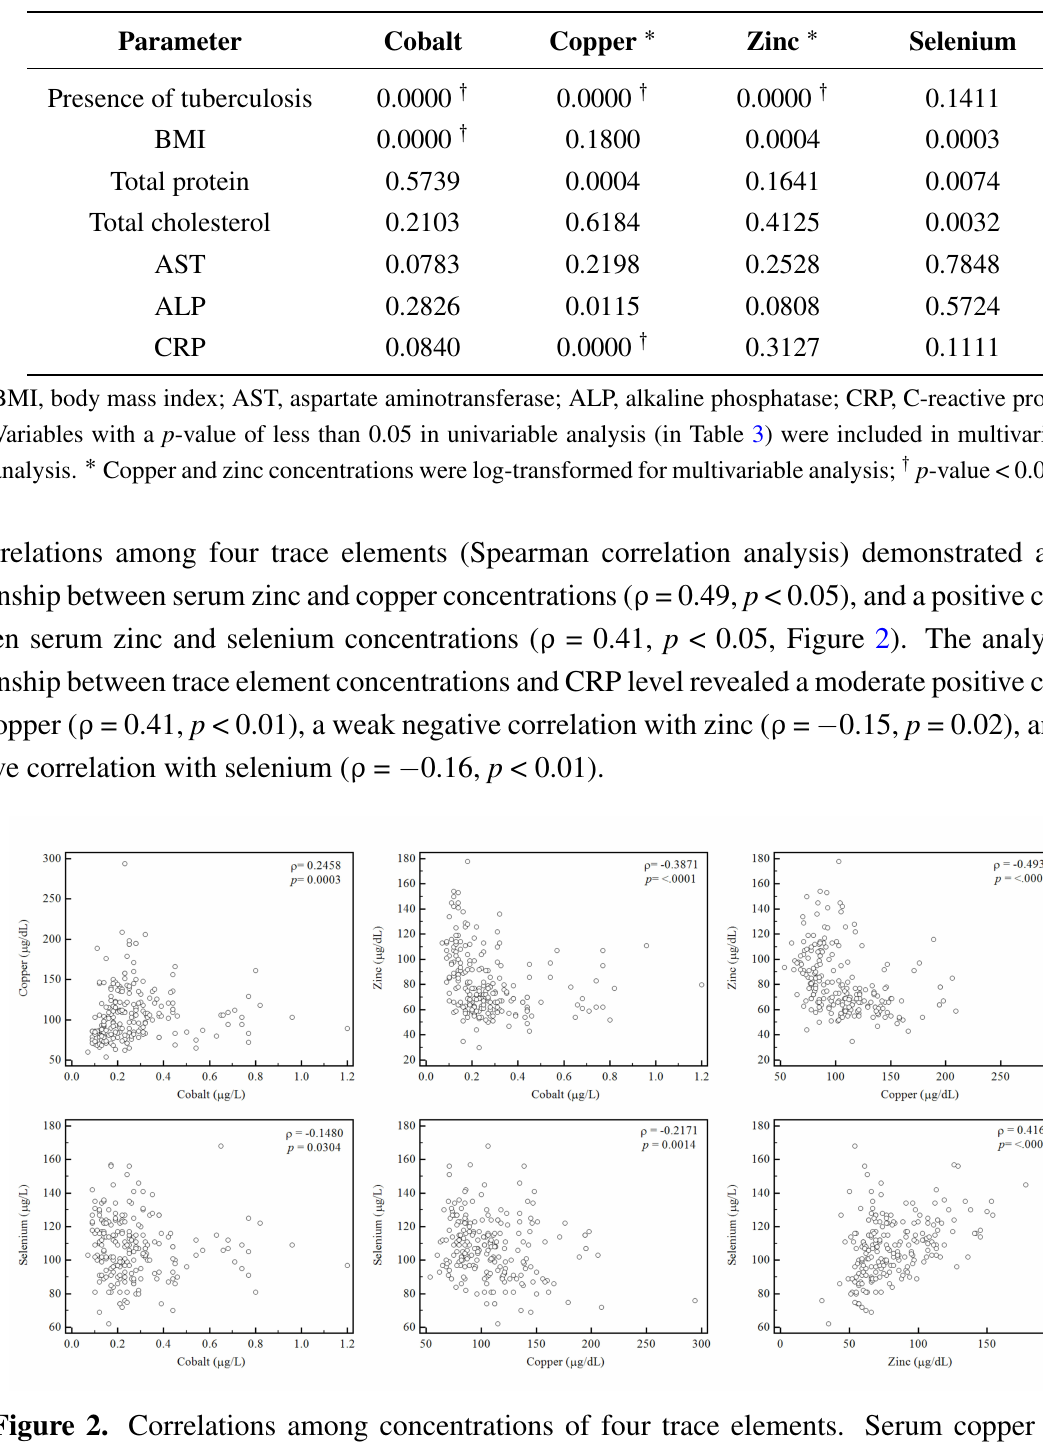
Table 4. Factors associated with four trace element concentrations: p -values for multivariable analysis.